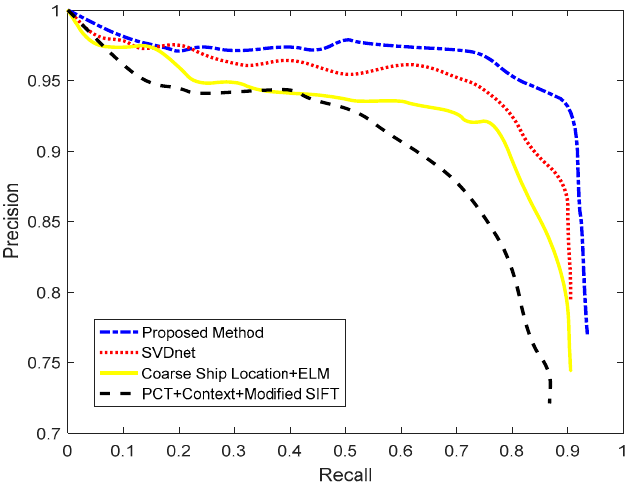
Figure 12. Ocean ship detection performances analysis. Figure 13. Ocean ship detection performances